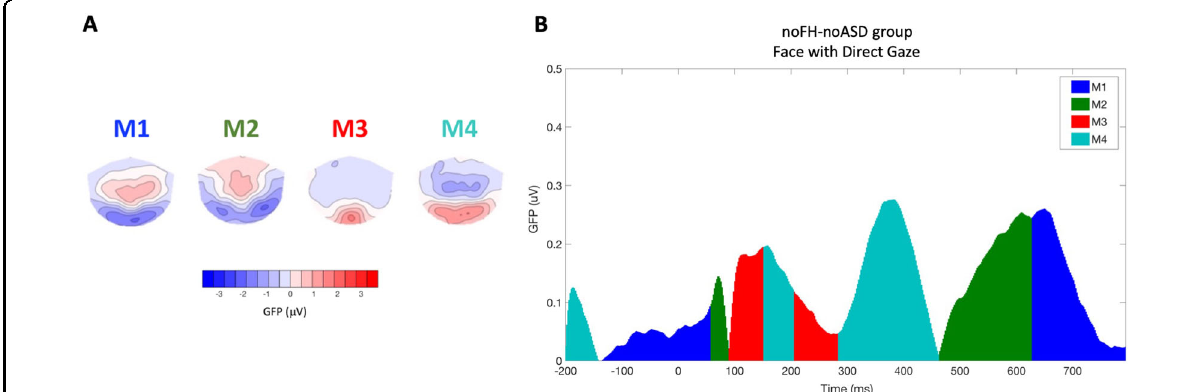
Fig. 2 The ‘ prototypical ’ microstates during social attention. A Scalp fi eld topography of the four optimal microstate maps estimated from infants with no Family History without a diagnosis of ASD at three years (noFH-noASD) in response to the face with direct gaze stimulus. Normalised amplitude (GFP) in the microstate ranges from − 3.5 (blue) to 3.5 (red) microvolts. B Sequence of microstates in response to the face with direct gaze stimulus between − 200 and 794 milliseconds (on the x -axis). The blue area indicates that the topography of the scalp fi eld re fl ects microstate map 1 (M1), green re fl ects microstate map 2 (M2), red re fl ects microstate map 3 (M3) and cyan re fl ects microstate map 4 (M4). On the y -axis, absolute values of the mean GFP for each time-stamp, in microvolts, are